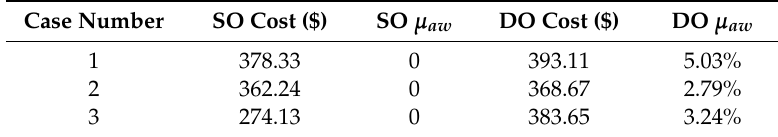
Figure 10. Sensitivity analysis of the capacity of electrical storage. Table 4. Comparison of the results of methods stochastic optimization (SO) and deterministic optimization (DO) in scenario 10.